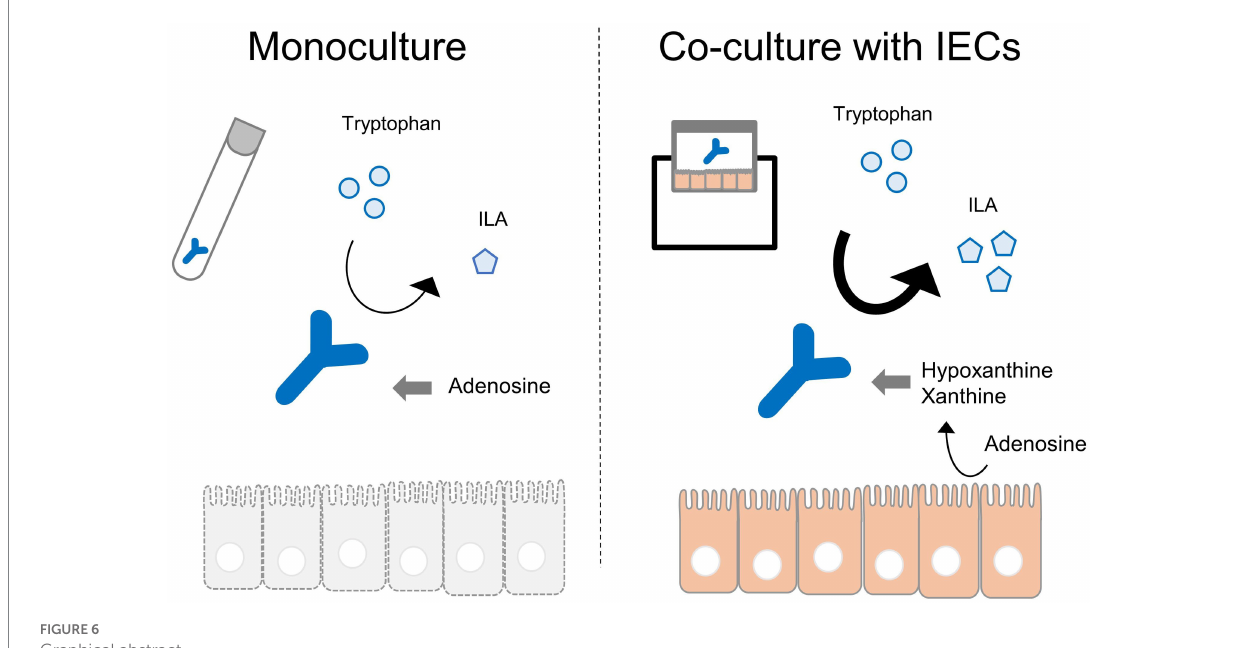
FIGURE 6 Graphical